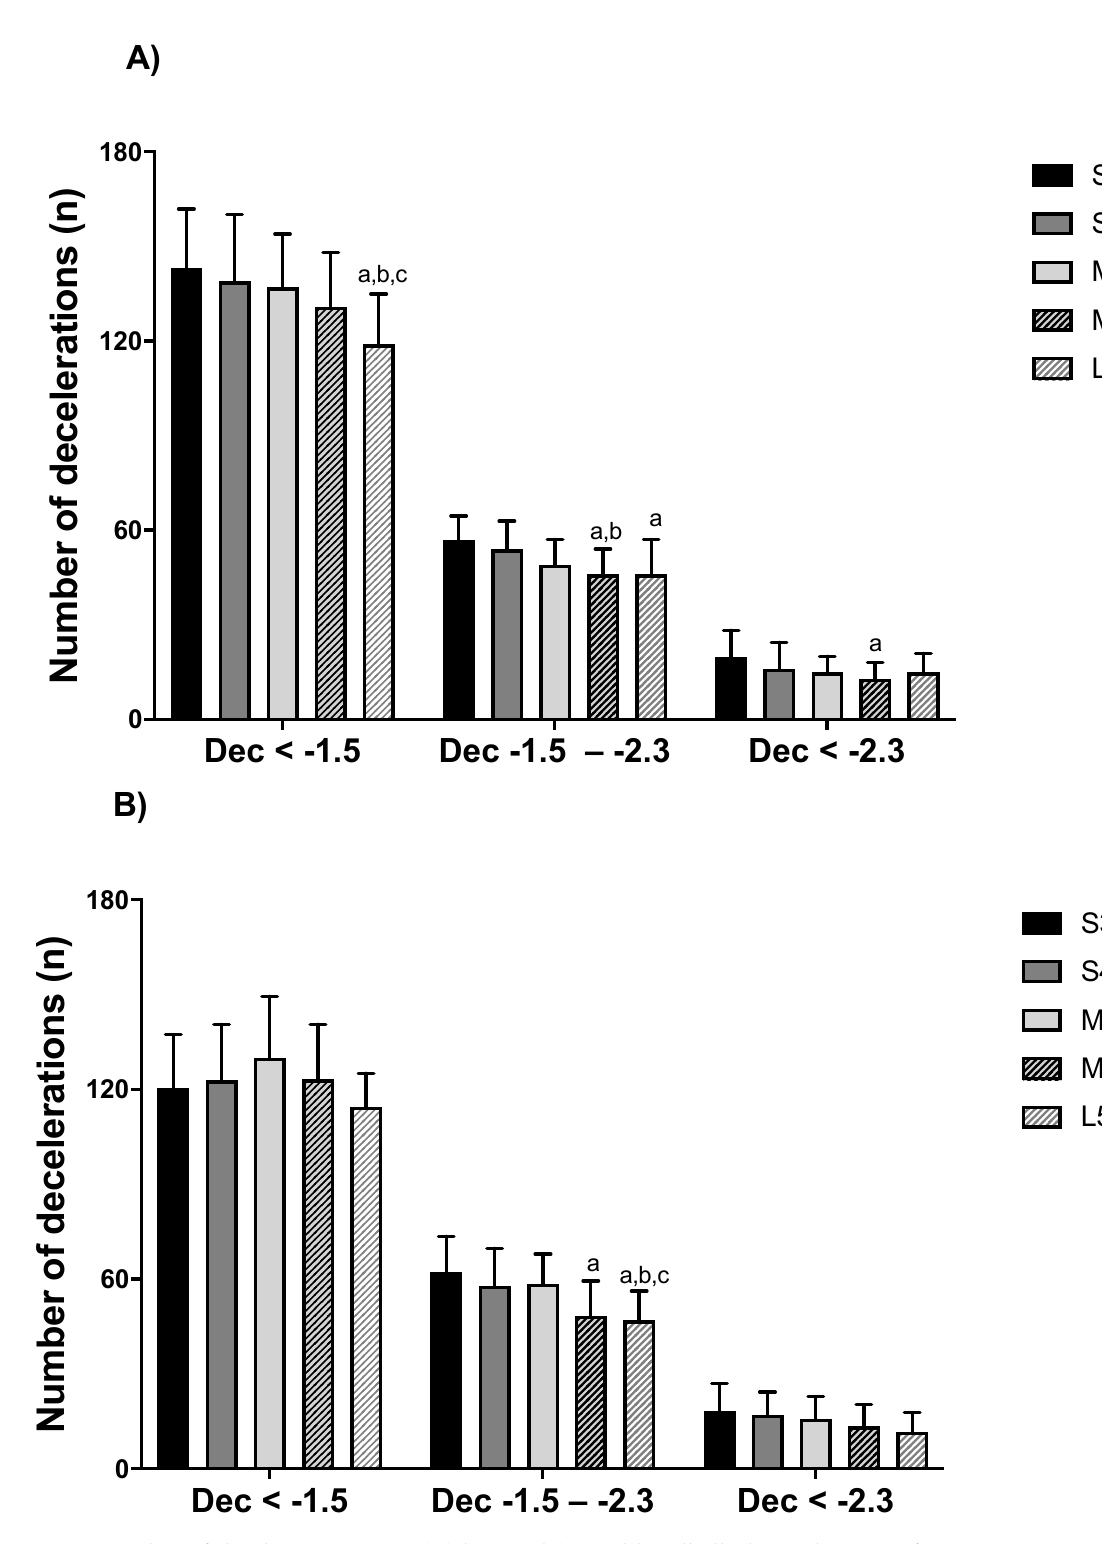
Figure 3. Number of decelerations in U9 ( A ) boy and ( B ) girl handball players by game formats. S3 + 1: small size, 3 v 3 + offensive goalkeeper; S4: small size, 4 v 4; M4: medium size, 4 v 4; M5: medium size, 5 v 5; L5: large size, 5 v 5. a denotes significant differences compared to S3 + 1; b to S4; c to M4 ( p ≤ 0.05).